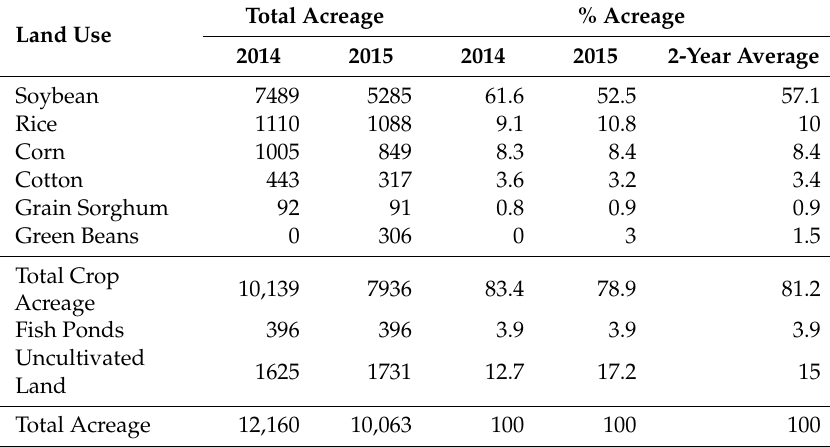
Figure 4. Dominant land use within a two-mile radius around the Low-Ag site in 2014. This landscape was primarily composed of woodland and grassland/pasture, with a small area of wheat, and some commercial fish farming.